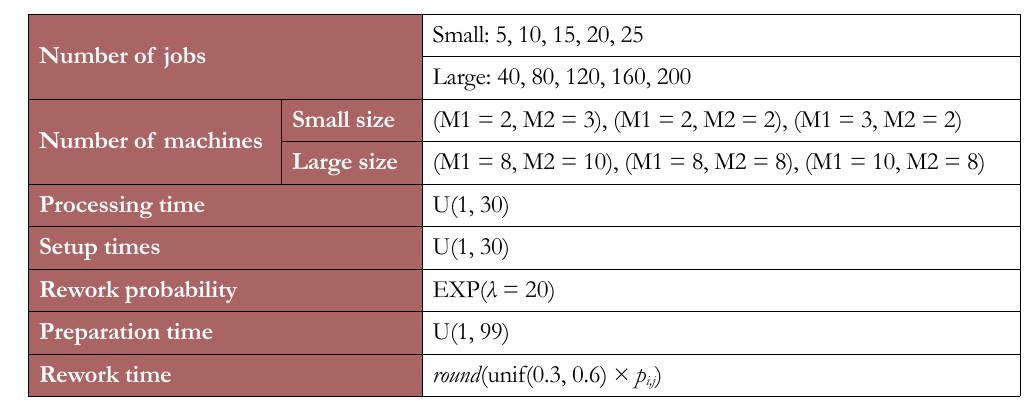
Table 1. Parameters and their levels